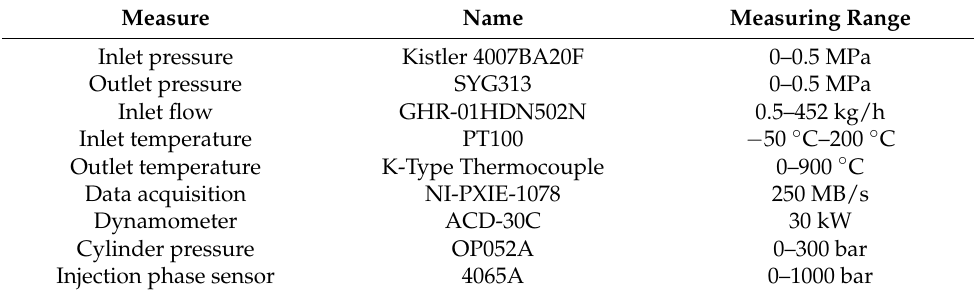
Figure 4. Rate of injection profile test bench. Detailed parameters are shown in Table 2. Table 2. Equipment parameters.